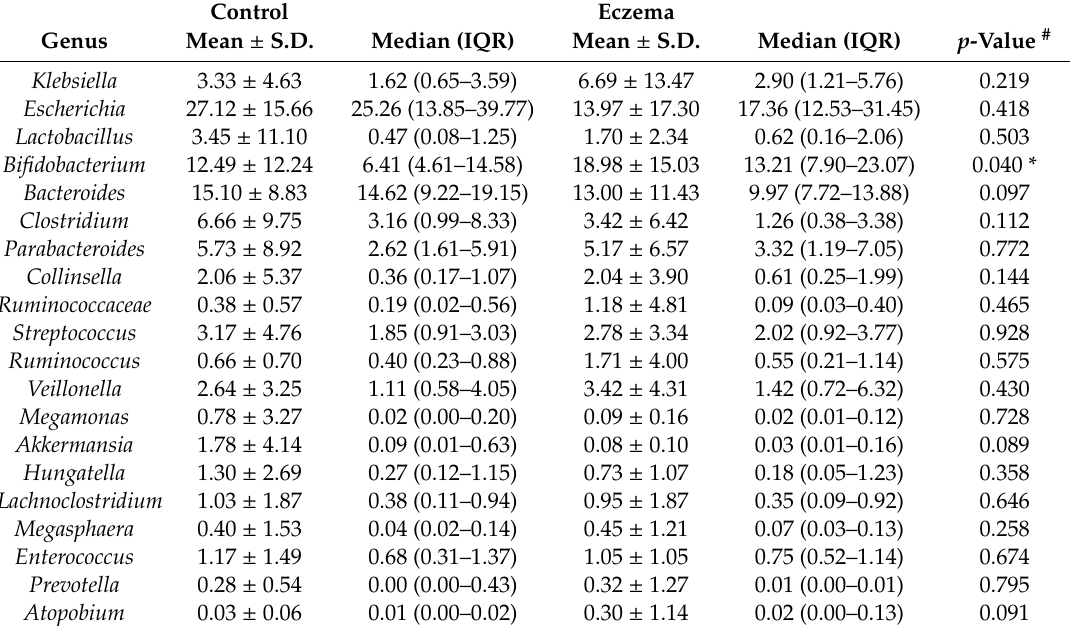
Table 2. The relative abundances of the dominant 20 bacterial genera in stool samples obtained at four months of age from 24 eczema cases and 24 control subjects.